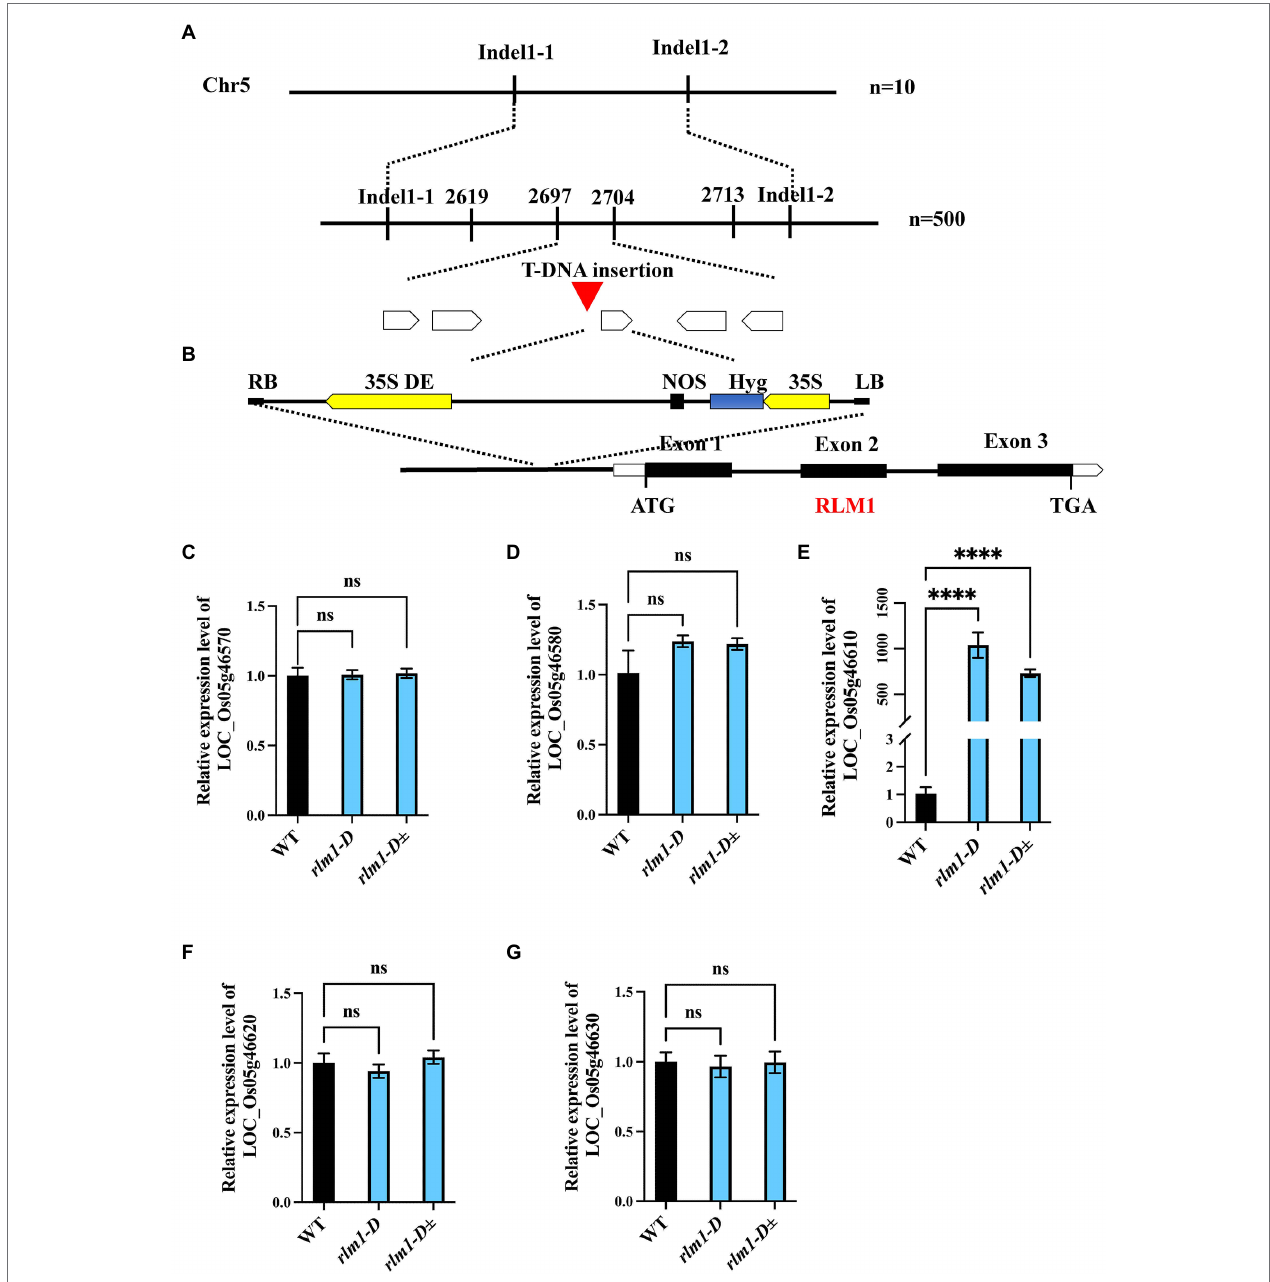
FIGURE 3 | Map-based cloning of RLM1. (A) The RLM1 locus was mapped to a 2.5 cM interval on chromosome 5, between Indel markers Indel1-1 and Indel1-2. The location of the RLM1 locus was narrowed to a 10 kb region between insertion–deletion (InDel) markers 2,697 and 2,704 via 500 F2 WT-like plants. (B) The T-DNA insert site is located upstream of LOC_Os05g46610. The structure of RLM1 is shown. ATG and TGA, start and stop codons, respectively. Boxes, exons; lines between black boxes, introns. (C–G) Expression analysis of LOC_Os05g46570, LOC_Os05g46580, LOC_Os05g46570610, LOC_Os05g46620, and LOC_ Os05g46630 in WT, rlm1-D , and heterozygous ( rlm1-D ±) plants. **** p < 0.0001 (Student’s t